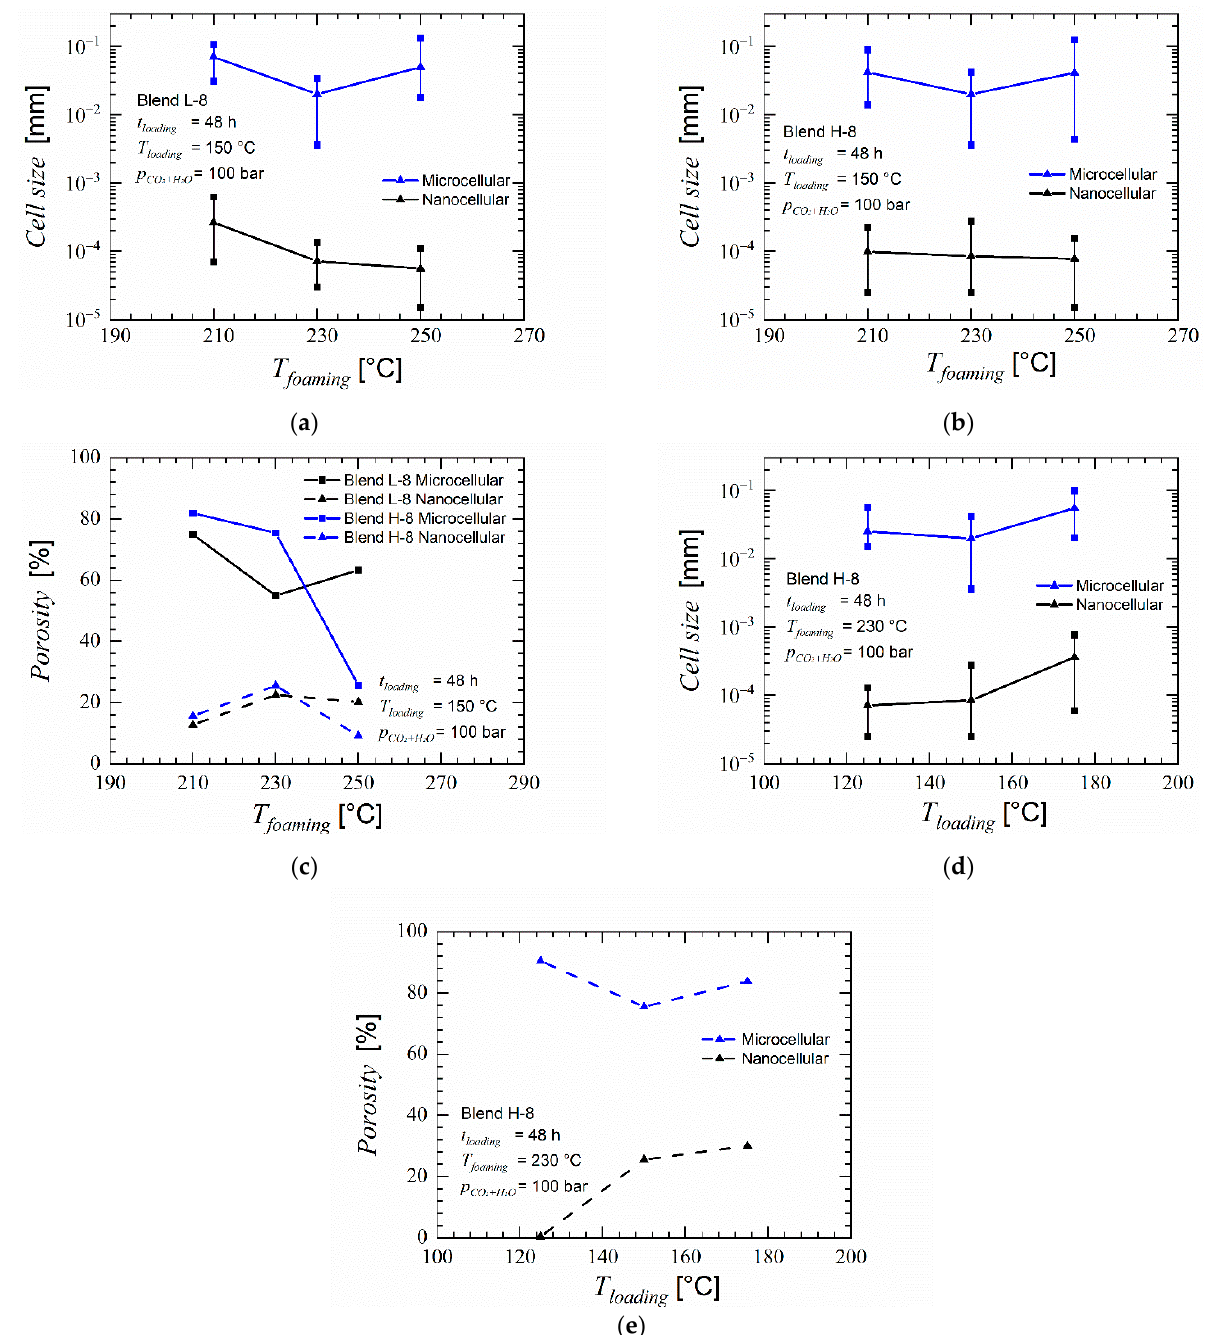
Figure 9. Average cell size and porosity: ( a ) Average cell size vs. foaming temperature in foams of blend L-8; ( b ) Average cell size vs. foaming temperature in foams of blend H-8; ( c ) Porosity vs. foaming temperature in foams of blends L-8 and H-8; ( d ) Average cell size vs. loading temperature in foams of blend H-8; ( e ) Porosity vs. loading temperature in foams of blend H-8.